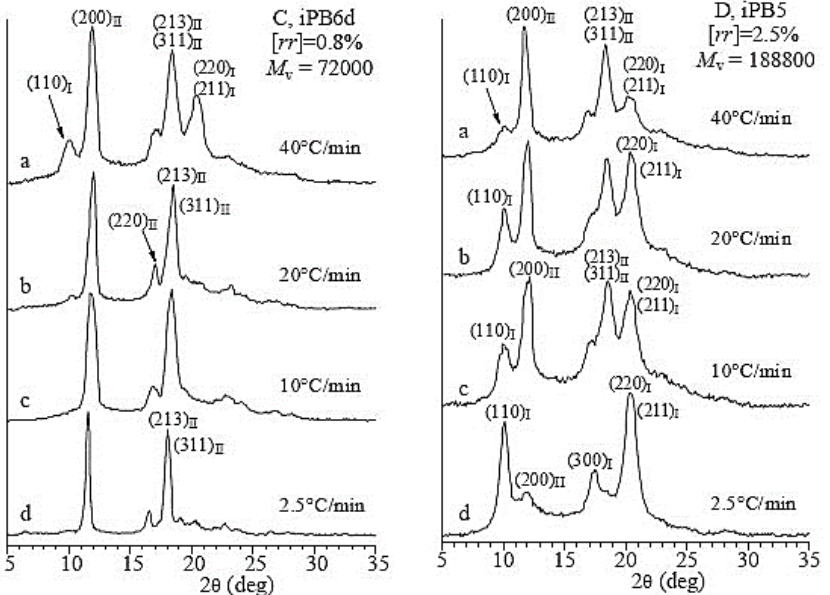
Figure 11. X-ray powder diffraction profiles of samples of iPBu of different stereoregularity crystallized from the melt by cooling the melt to room temperature (or lower temperature) at the indicated cooling rates. The (110) I , (300) I and (220) I /(211) I reflections of form I at 2 θ = 9.9 ◦ , 17.3 ◦ , and 20.5 ◦ , and the (200) II , (220) II and (213) II /(311) II reflections of form II at 2 θ = 11.9 ◦ , 16.9 ◦ , and 18.3 ◦ are indicated. Reproduced with permission from Ref. [80], copyright 2009 American Chemical Society.